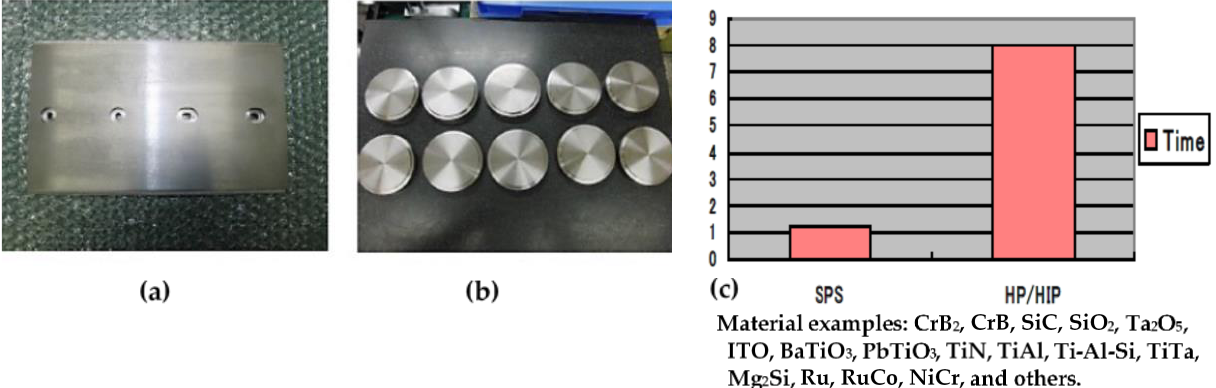
Figure 38. Example of commercialized large-size sputtering target materials: ( a ) 250 × 150 mm square-shaped metallic sputtering target; ( b ) Φ 100 mm targets after mechanical finishing; and ( c ) typical working time comparison of SPS vs. HP/HIP.